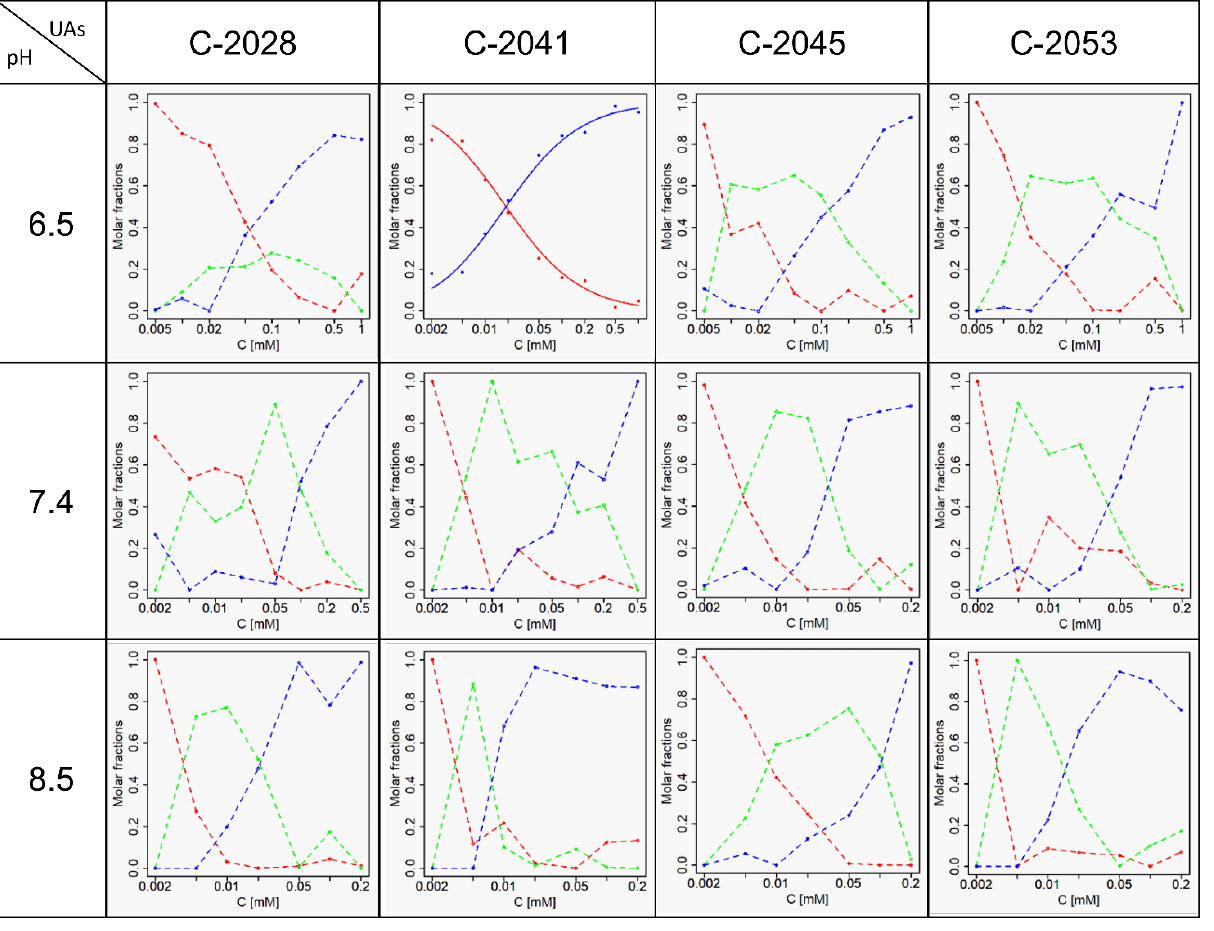
Figure 8. Molar fractions of UAs at pH = 6.5, 7.4, 8.5 at 35 ◦ C. Dotted curves—molar fractions of individual self-associates, solid curves—the best fit of the theoretical model. Red color—monomer, green color—first order aggregate (presumably a dimer), blue color—higher order aggregate. Table 3. Self-association constants (K) with SD at various pH values at 35 ◦ C. Constants marked by ‘*’ were determined via leave-one-out cross